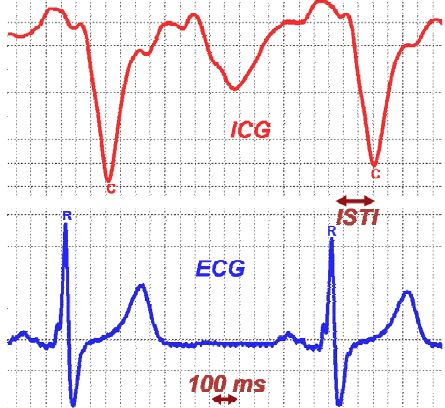
Fig.2: Simultaneous registration of an Impedance CardioGram (ICG) and an ElectroCardioGram (ECG) (arbitrary units). ISTI is defined as the time interval between the R-point in the ECG and the C-point in the ICG.